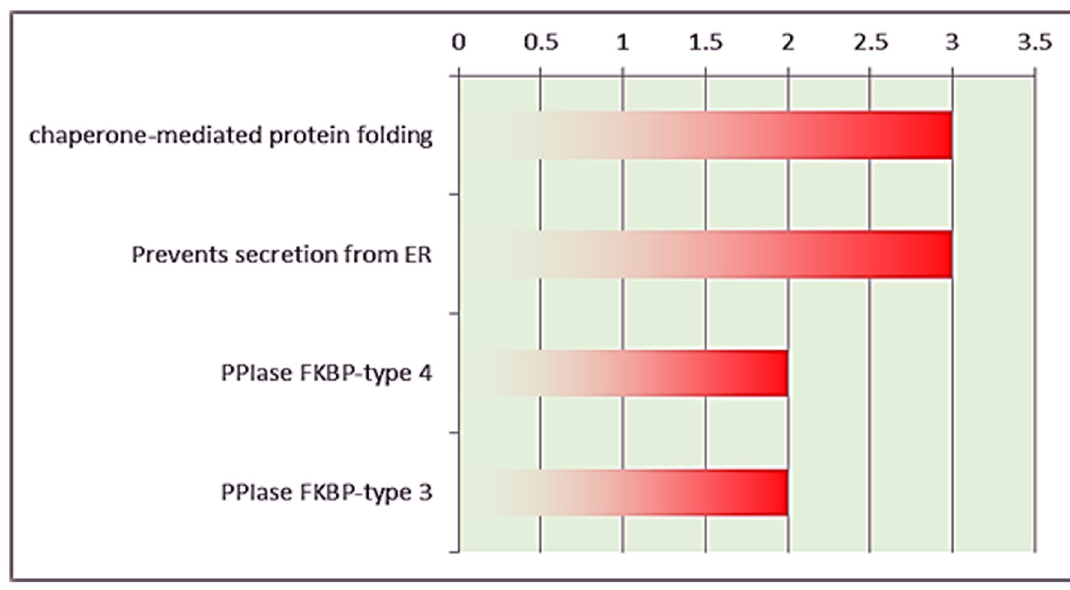
Fig 4. DAVID analysis for stage 2 breast cancer